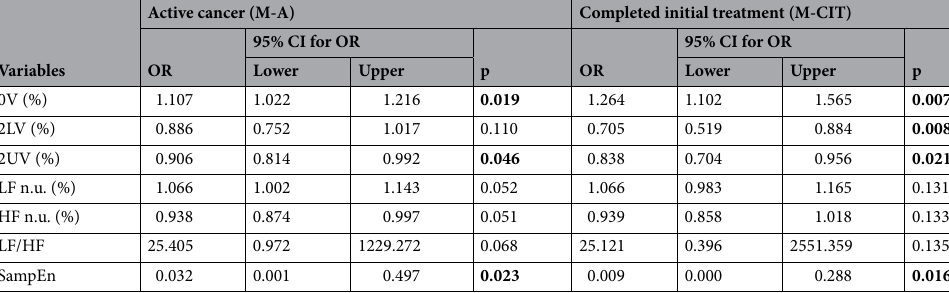
Table 4. Survivors regression models (adjusted for age, BMI, Mean HR, and RR). Active cancer (M-A)— control and benign group as negative outcome, M-A group as positive outcome; completed initial treatment (M-CIT)—control and benign group as negative outcome, M-CIT group as positive outcome. Bold values of p indicate statistical significance (value of p < 0.05). 0V zero variation, 2LV two like variations, 2UV two unlike variations, CI confidence interval, HF n.u. high-frequency normalized power, HF/LF ratio between LF and HF band powers, LF low-frequency normalized power, OR odds ratio, SampEn sample